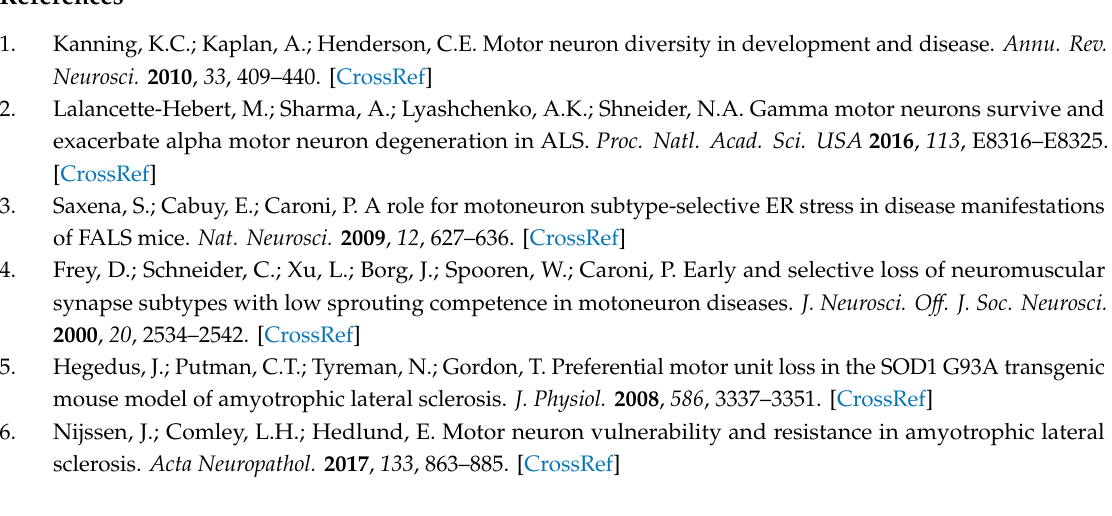
Figure S1: Misfolded SOD1 protein is not detected in the cortex of WT-UeGFP reporter mouse, Figure S2: Misfolded SOD1 protein is not detected in the spinal cord of WT-UeGFP reporter